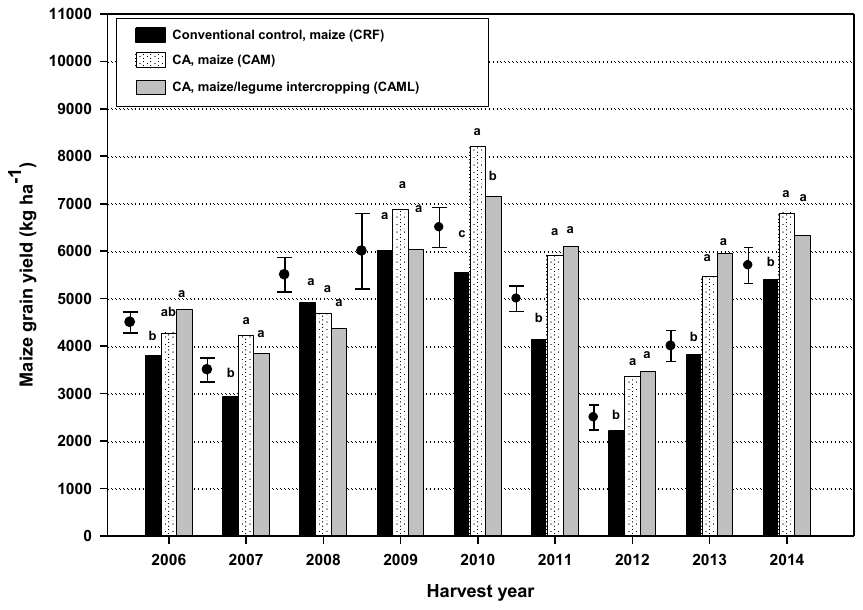
Figure 1. Long-term effects of a conventional and two conservation agriculture treatments on maize grain yield (kg·ha −1 ) in Zidyana, Nkhotakota District, Malawi, 2006–2013. The error bars indicate the standard error of the difference (SED) at p ≤ 0.05. adapted from [40].